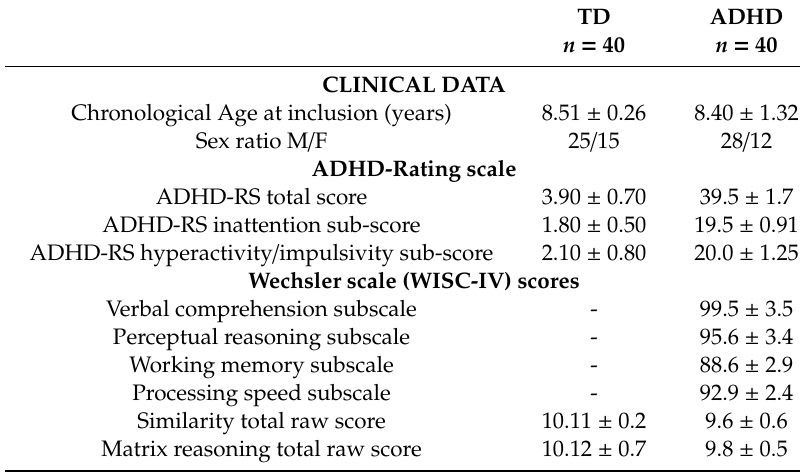
Table 1. Clinical characteristics of children with typical development (TD) and with attention-deficit / hyperactivity disorder (ADHD) enrolled in the study. TD ADHD n = 40 n = 40 CLINICAL DATA Chronological Age at inclusion